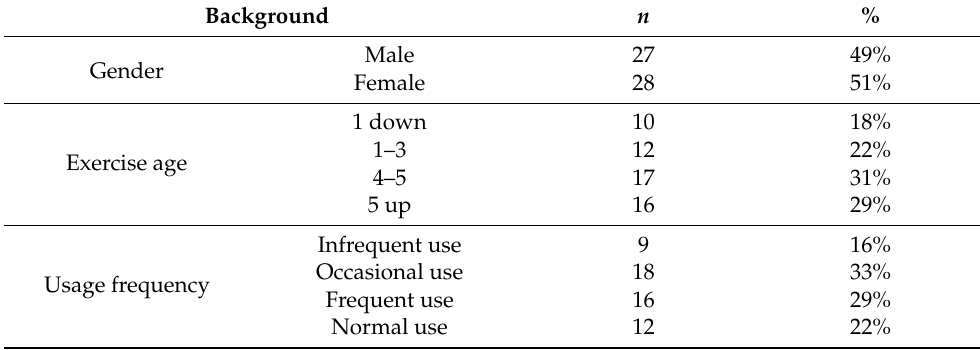
Table 3. Background